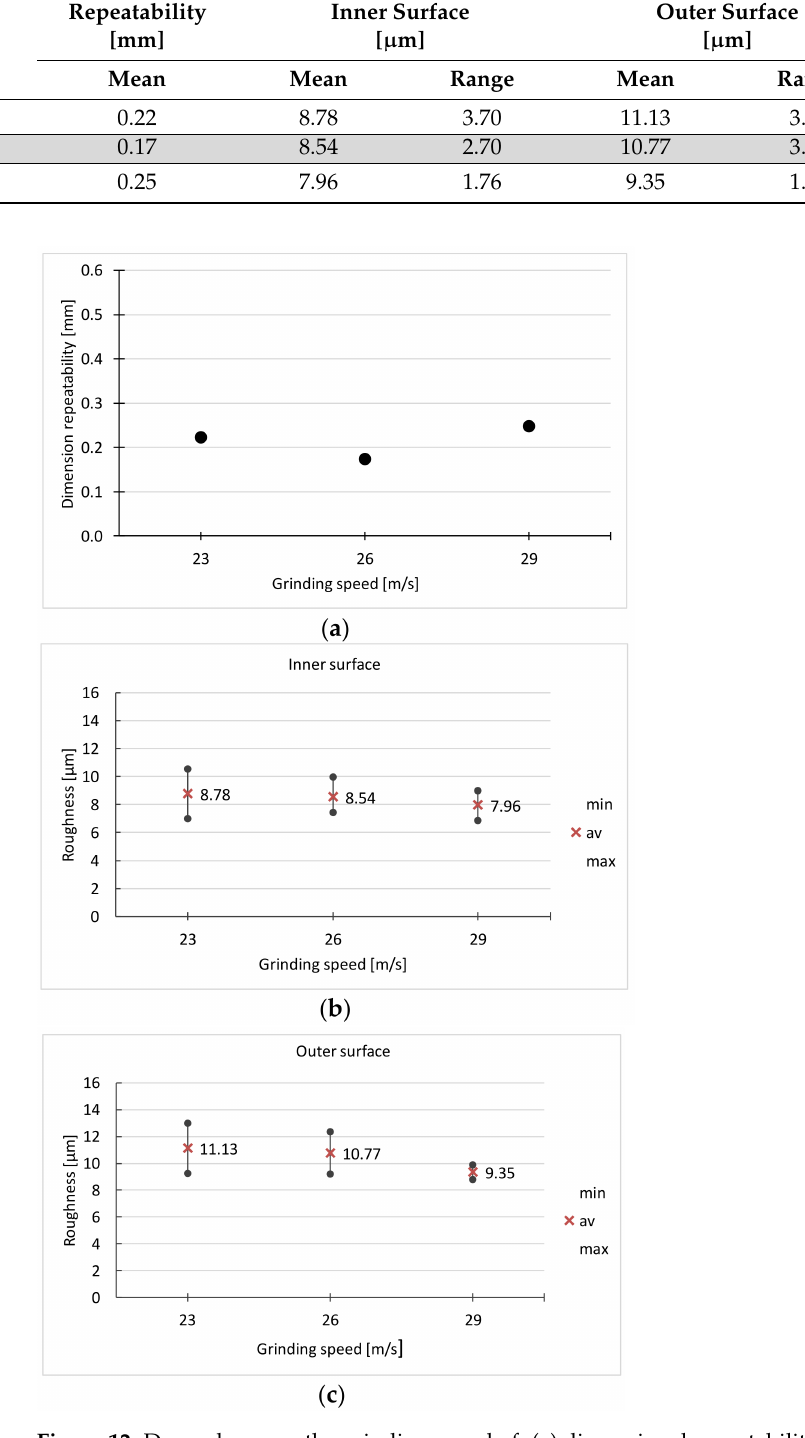
Figure 12. Dependence on the grinding speed of: ( a ) dimensional repeatability, ( b , c ) surface rough- ness ( F n = 10 N, v f = 4